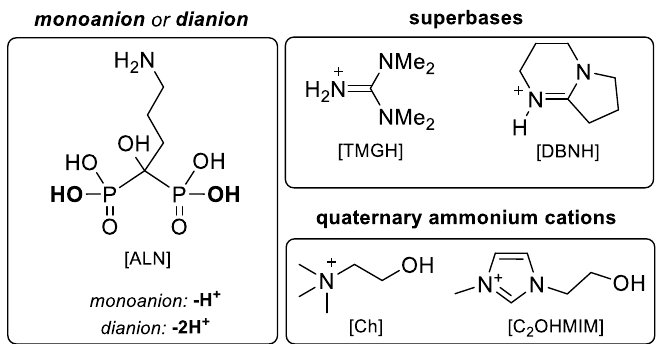
Figure 1. Structure of mono- and dianionic alendronate, protonated superbases and organic quaternary cations used to prepare the alendronic acid (ALN)–Organic Salts and Ionic Liquids (OSILs). Scheme 1 resumes the synthetic methodologies employed in the synthesis of the API–OSILs.